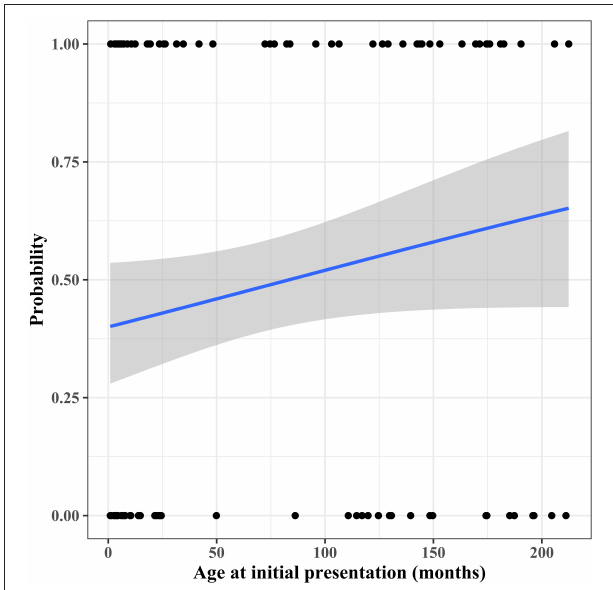
FIGURE 6 | Probability curve for cardiac events within 2 years after initial presentation according to age at initial presentation.